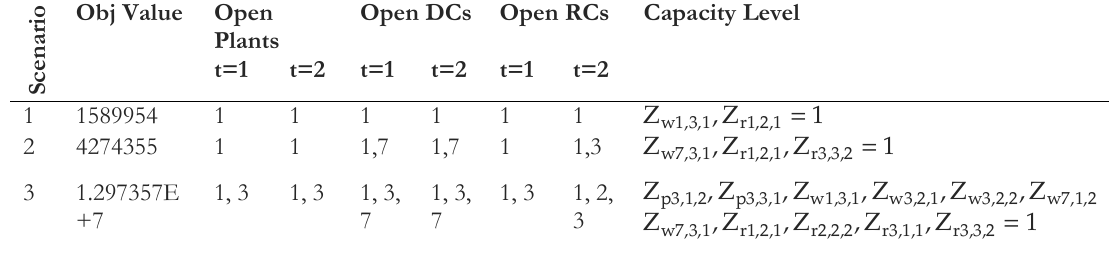
Table 7. Small test instance solution in each scenario.